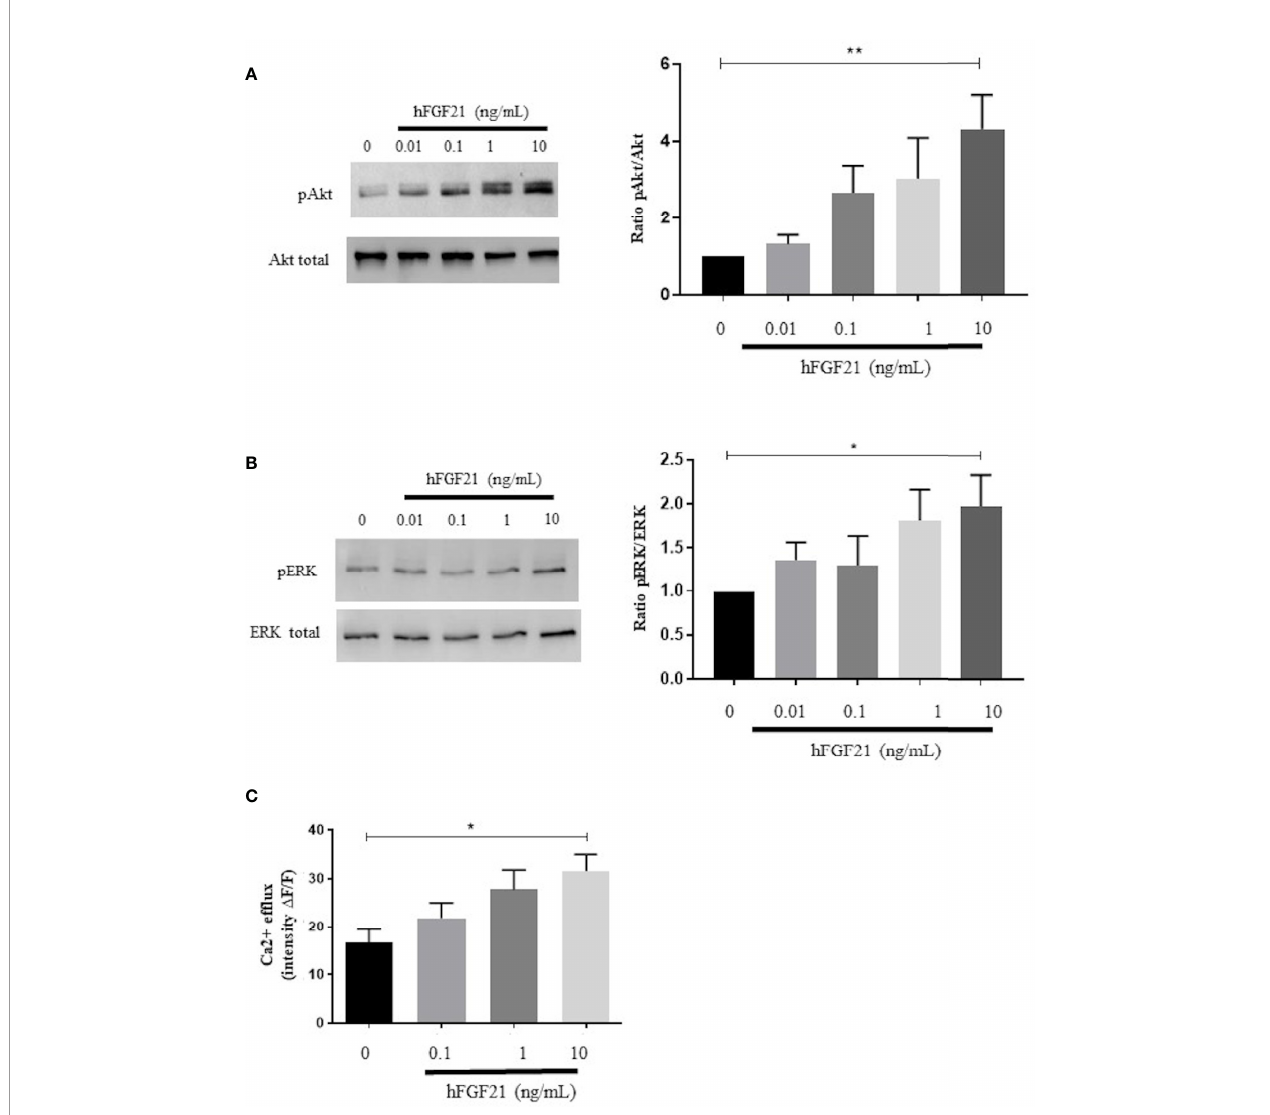
FIGURE 4 | Signaling pathways activated by the exposure of human spermatozoa to FGF21. (A, B) Western blot and analysis of phosphorylated (ser473) Akt and phosphorylated (Thr202/Tyr204) ERK in human spermatozoa exposed to recombinant FGF21 (0.01-10 ng/mL), as described in Materials and Methods section. Results are representative of at least four independent experiments. (C) Intracellular calcium responsiveness of sperm to recombinant FGF21 stimulation determined by fl uorescence intensity relative to baseline ( D F/F) at 30 min. *p < 0.05, **p <